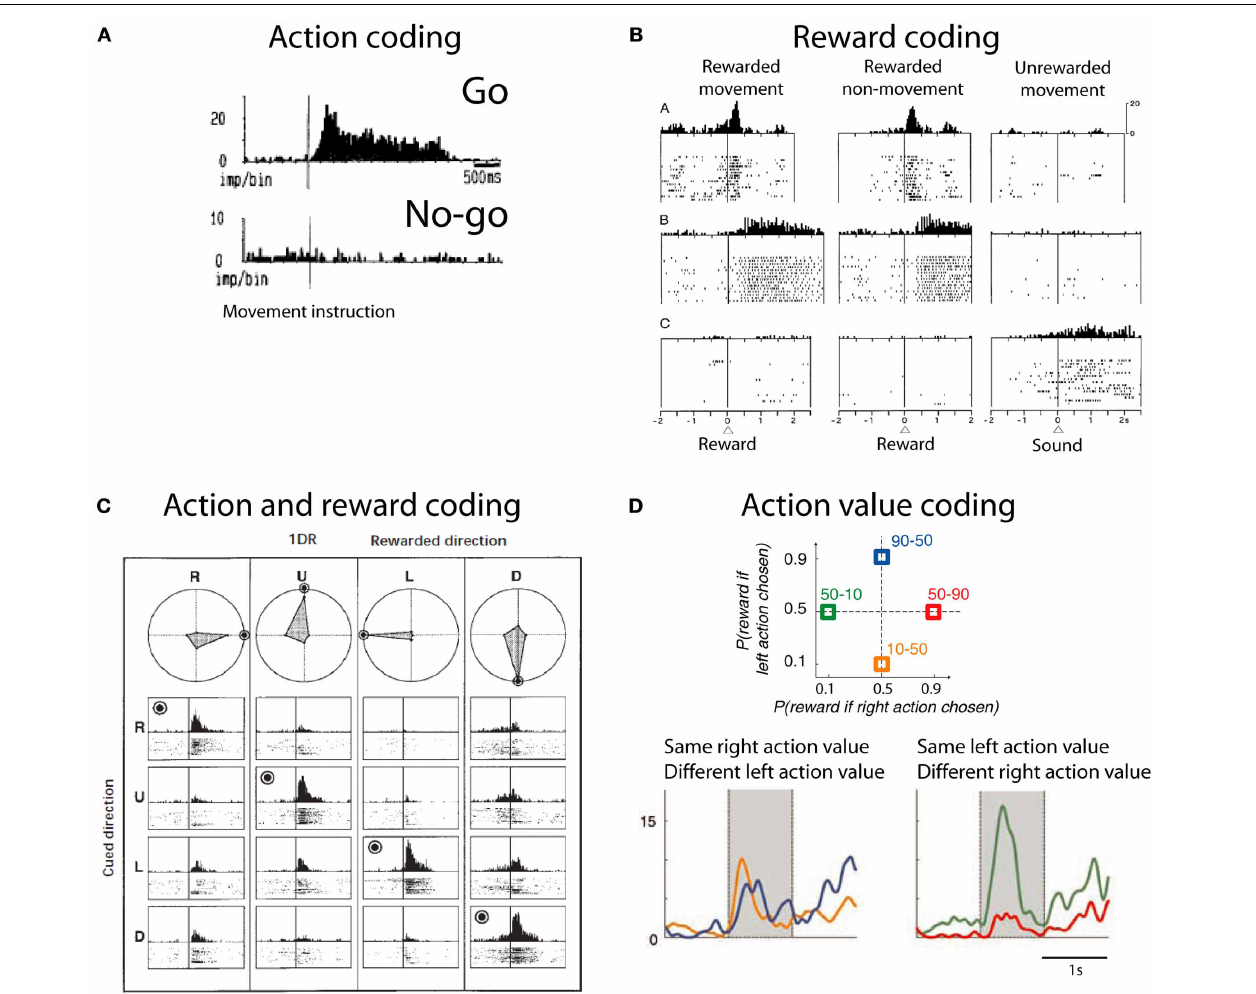
FIGURE 2 | Action and reward coding by striatal neurons. (A) Example striatal neuron active before movement (go) and silent before no-movement (no-go). Based on Schultz and Romo (1988), reproduced with permission. (B) Example striatal neurons coding reward. First row depicts a neuron with phasic active after juice reward delivery independent of the action to obtain reward. Second row depicts a neuron with tonic activity after juice reward delivery. Third row shows a neuron with tonic activity after no reward is delivered. Based on Hollerman et al. (1998), reproduced with permission. (C) Example caudate neuron coding the conjunction of action and reward. This